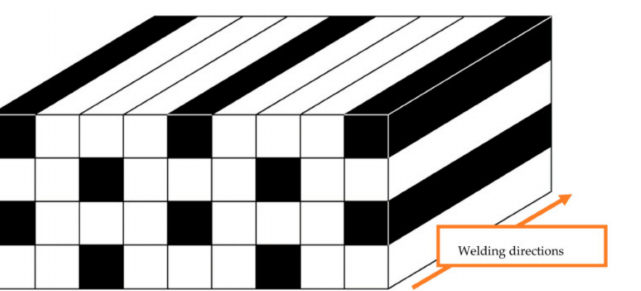
Figure 30. Fiber-like reinforcement of additive-manufactured material (white: soft material; black: strong material) [52,232].